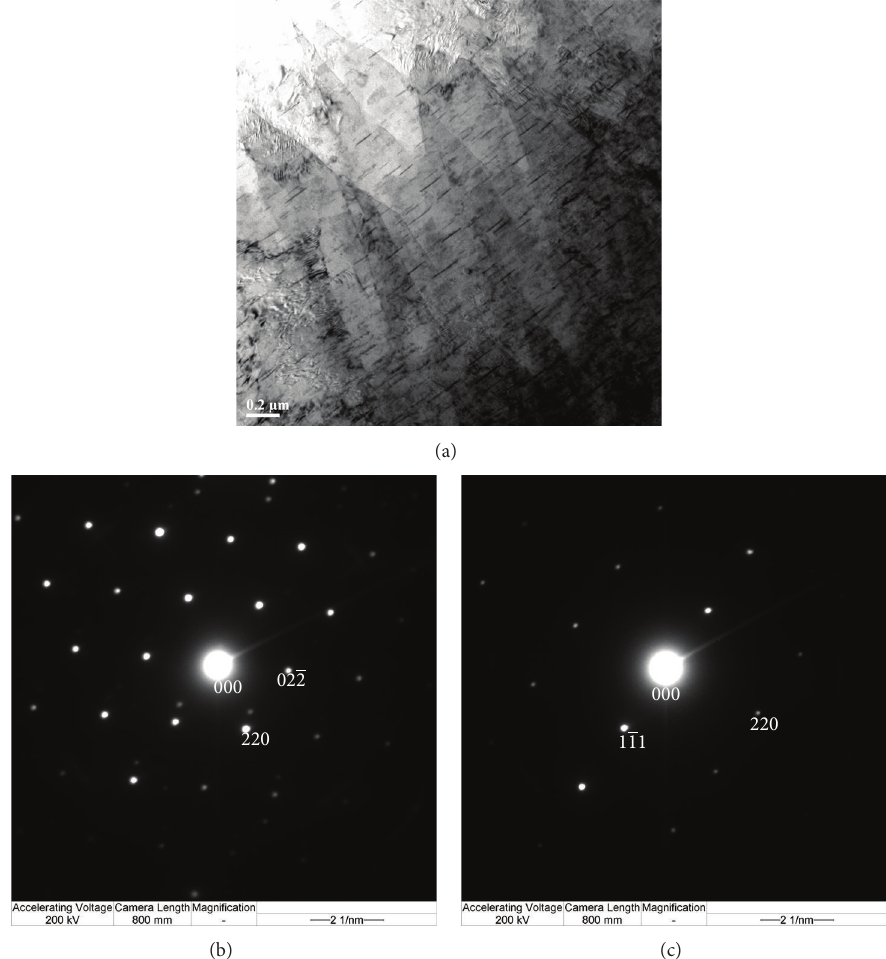
Figure 6: TEM image and electron diffraction pattern aged at 225 ∘ C for 8h: (a) and (b) along [111] 𝛼 zone axis; (c) along [112] 𝛼 zone